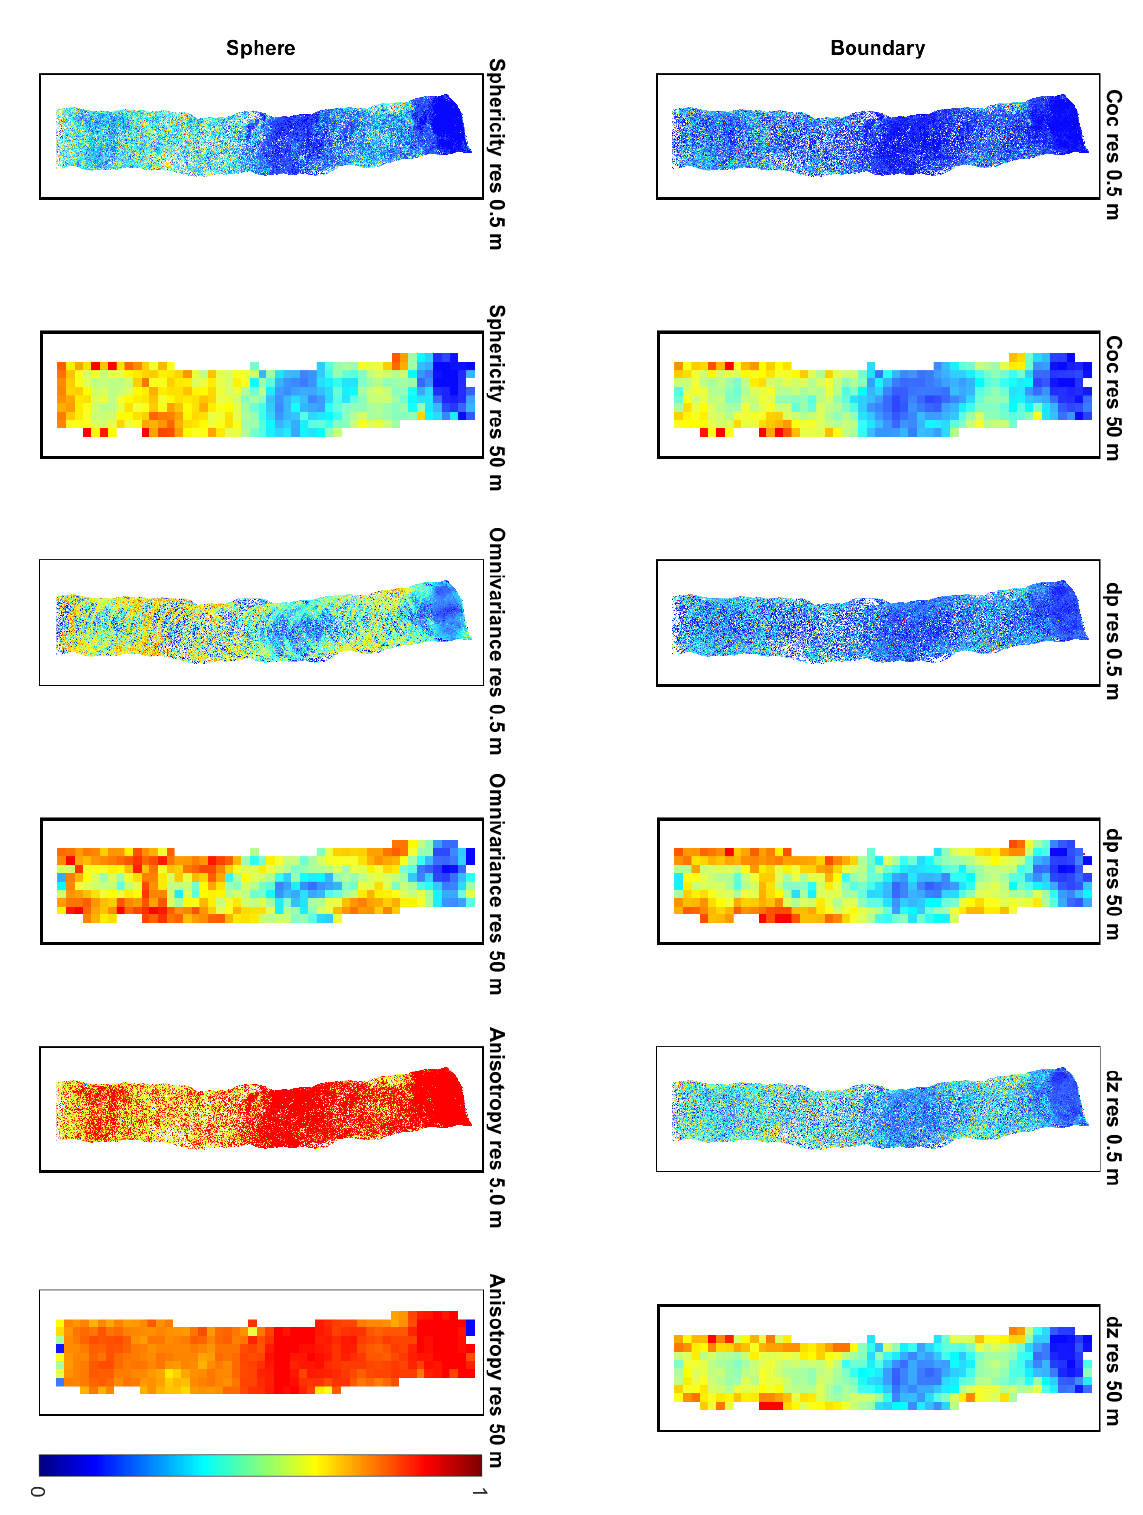
Figure 7. Normalized and centered predictors shown on a 0.5 m grid and on a 50 m grid for an area of 400 m × 2500